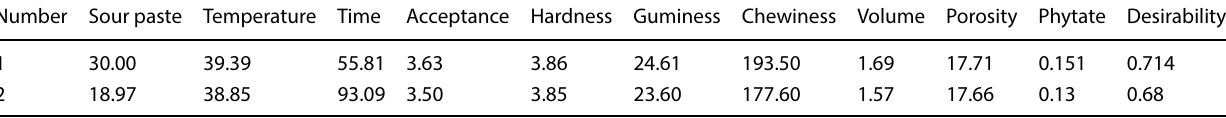
Table 4 Expected level for each answer and ranges obtained in the tests Number Sour paste Temperature Time